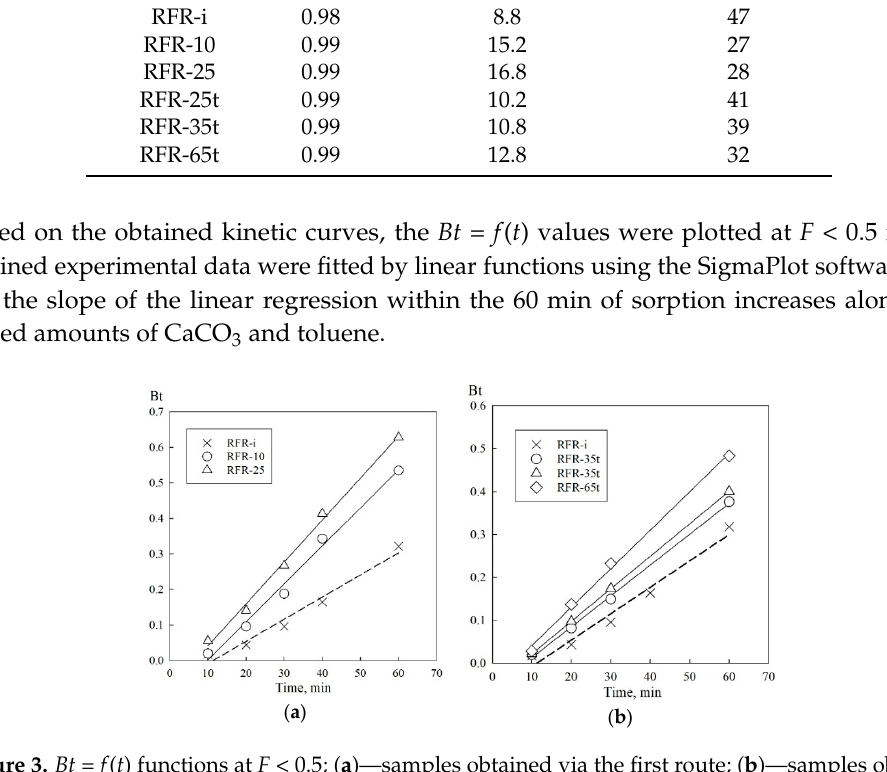
Figure 3. Bt = f ( t ) functions at F < 0.5; ( a )—samples obtained via the first route; ( b )—samples obtained via the second route. Table 1. D i and t 1/2 coefficients calculated using Boyd’s equation.